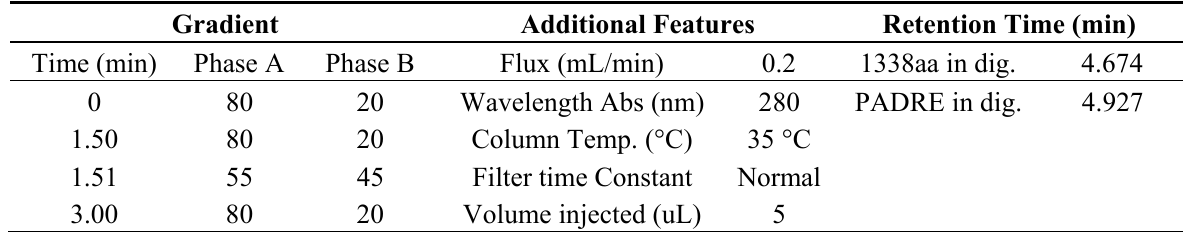
Table A1. UPLC conditions and peptide retention